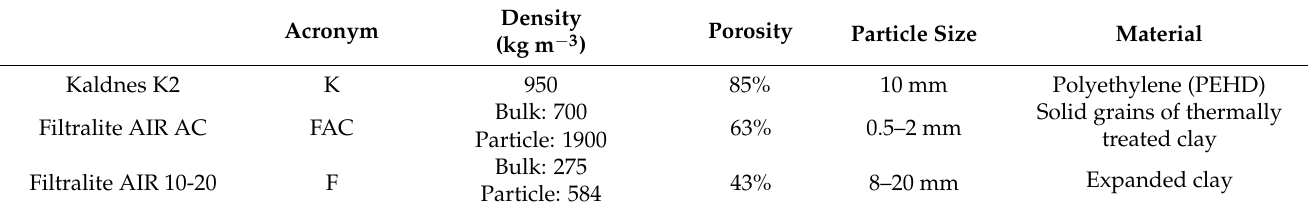
Figure 1. Schematic representation of the experimental setup (red: Phase I, blue: Phase II). Irrigation to the bioreactors (dotted lines) was either intermittent (BFs) or continuous (BTFs). SP: sampling port; MSM: mineral salt medium. Table 1. Main characterization parameters of the packing materials tested.